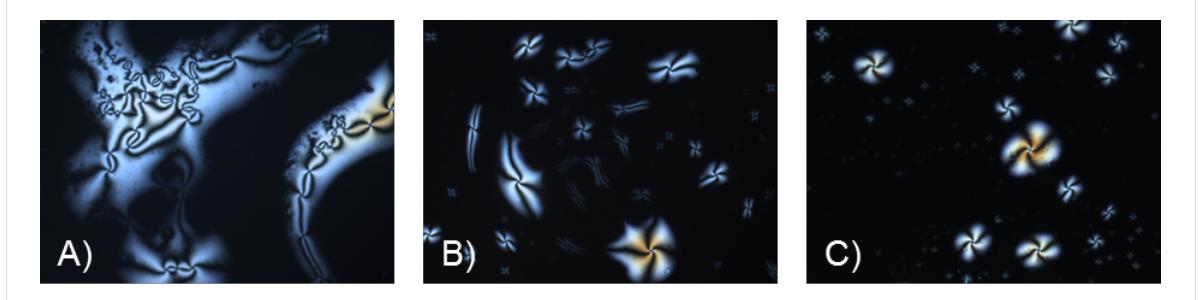
Figure 3: Schlieren textures of 11a and 11b under crossed polarizers, upon cooling (cooling rate 5 K/min) from the isotropic liquid (magnification 200×): (A) 11a (20 °C), (B) 11a (14 °C), (C) 11b (29 °C).